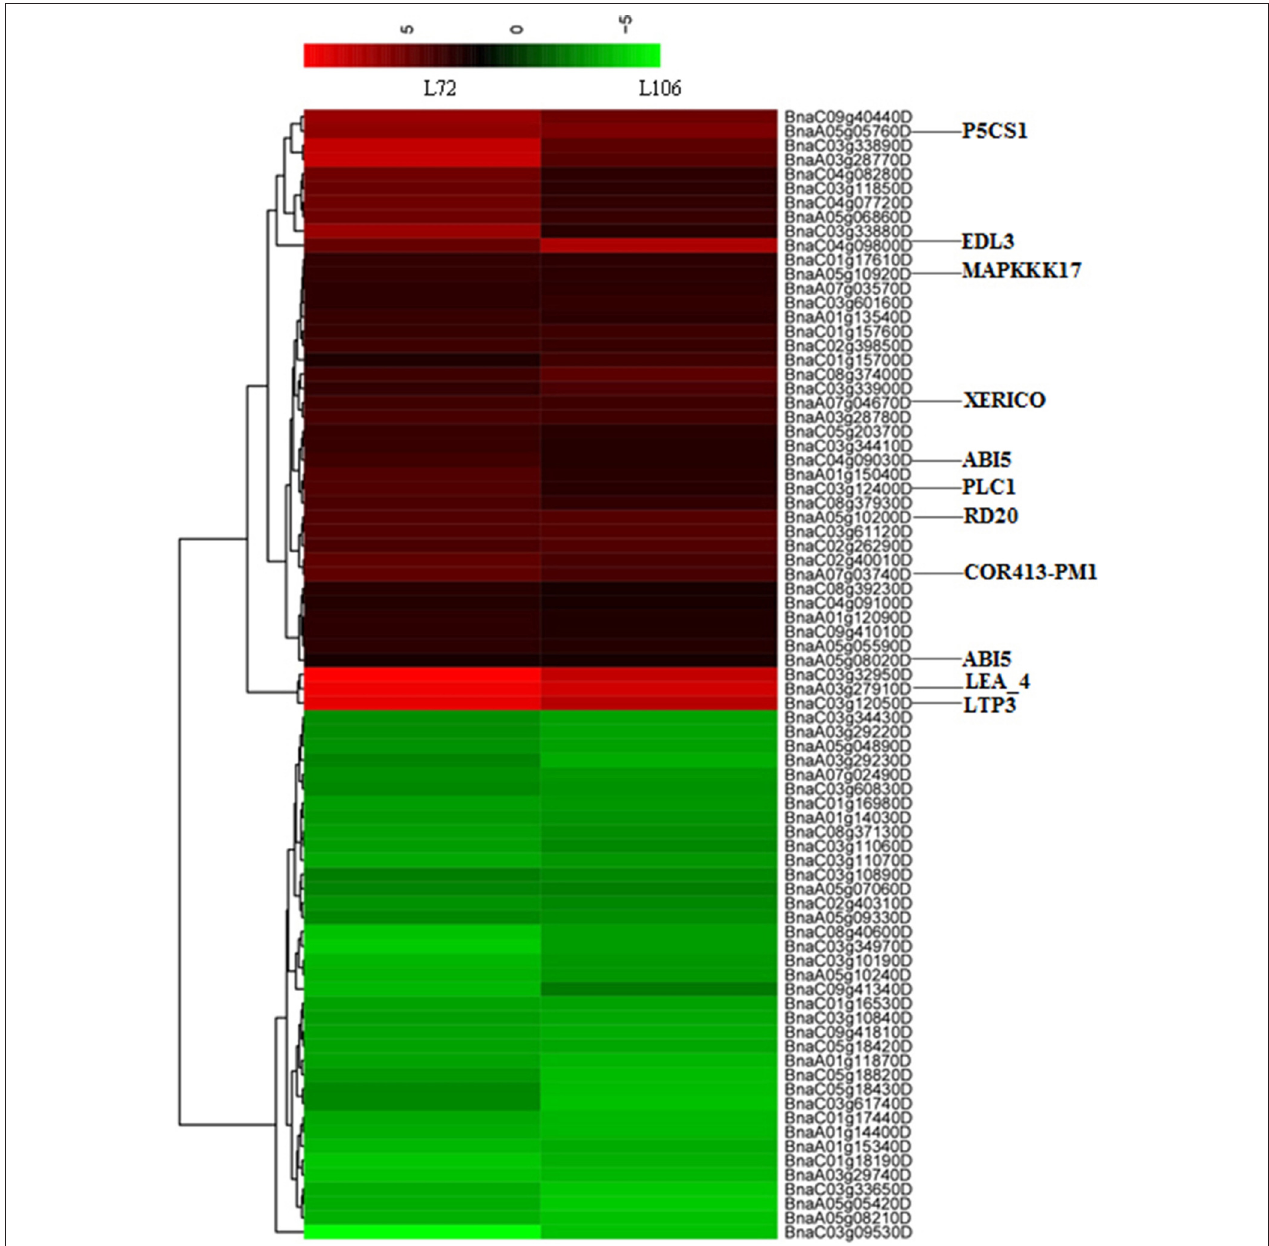
FIGURE 5 | Heatmap with hierarchical clustering showing differentially-expressed genes (DEGs) in two B. napus accessions (L72: MUTU and L106: Alku) within the vicinity of 1.0Mb of 16 uniquely identified SNPs associated with water stress tolerance phenotypes. The genes which were orthologs to drought-related genes in A. thaliana are